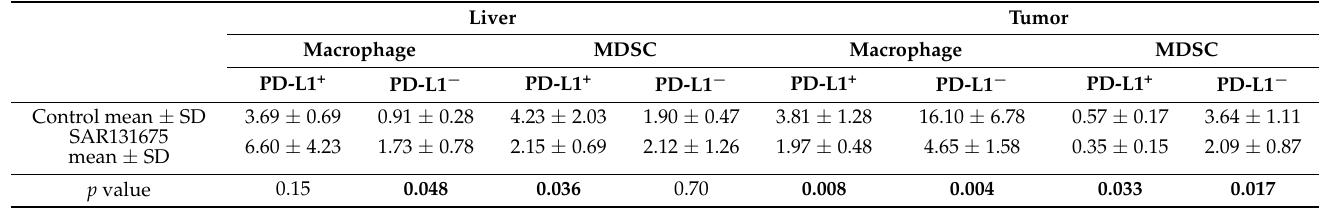
Table 3. Ratio of granulocytic (Ly6C low ) to monocytic (Ly6C high ) myeloid cells subsets in liver and tumor a . Liver Tumor